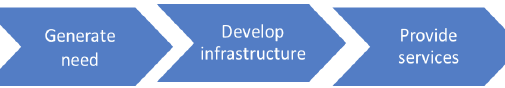
figure. 1. The traditional model of activities of public and local